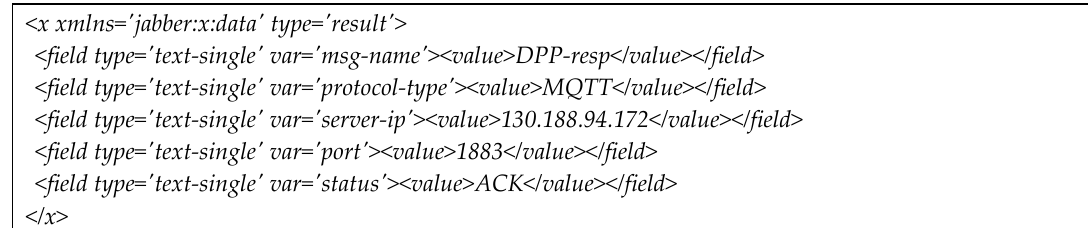
22 of 37 Figure 17. Data plane negotiation procedure. Request/response implementation is utilizing XMPP message stanza and “Data Form” XMPP extension [29]. That extension is identified by XML namespace called “jabber:x:data”. Fields with example values of the request message are expressed here in plain text. msg-name